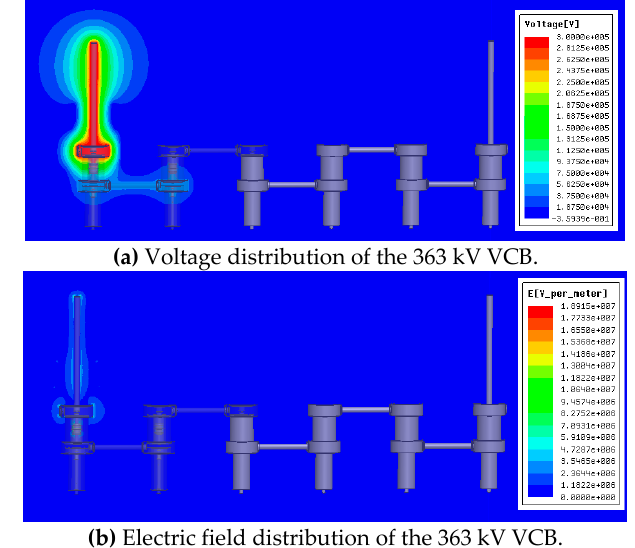
Figure 3. The mesh of the simulation model.